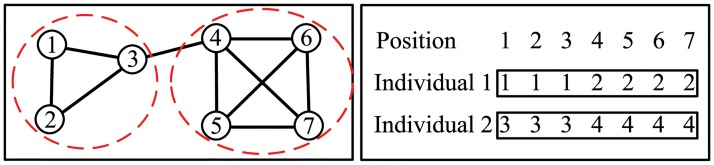
Illustration of group based representation.Left, a network with a community structure. Right, two possible representations corresponding to the community structure.